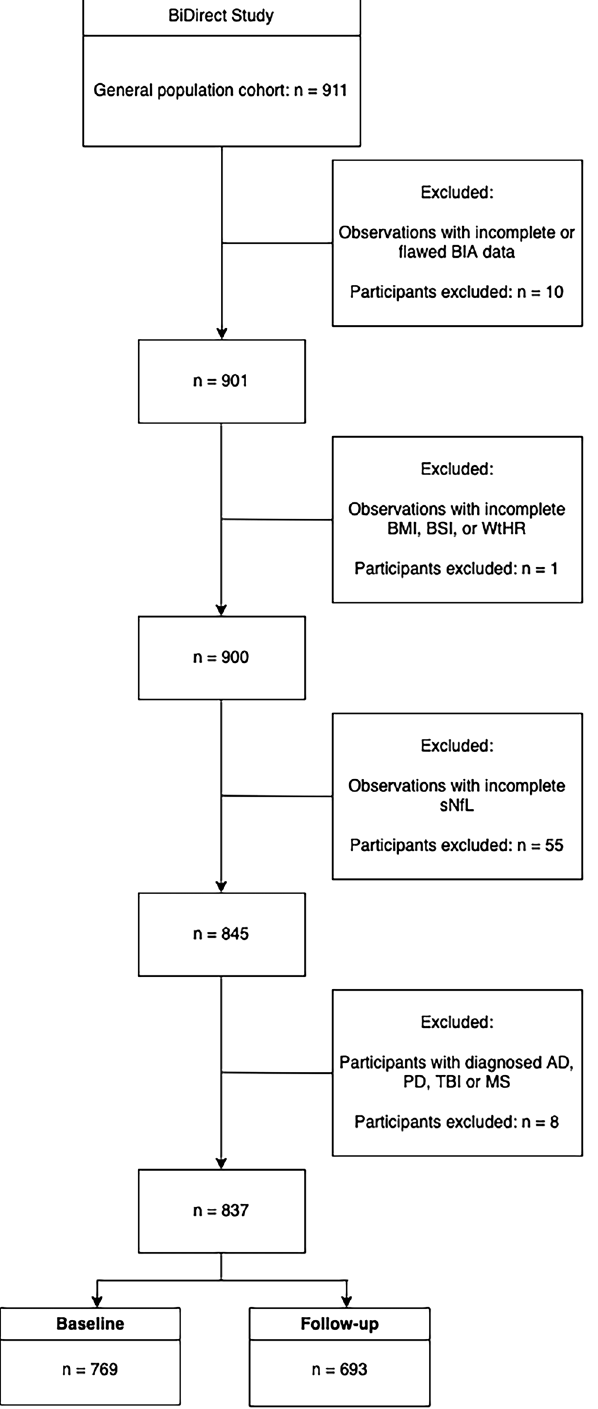
Figure 1. Flowchart illustrating the exclusion criteria and the number of participants considered for the analyses of both time points. Abbreviations : BIA, bioelectrical impedance analysis; BMI, body mass index; BSI, body shape index; WtHR, waist-to-height ratio; sNfL, serum neurofilament light; AD, Alzheimer’s disease; PD, Parkinson’s disease, TBI, traumatic brain injury; MS, multiple